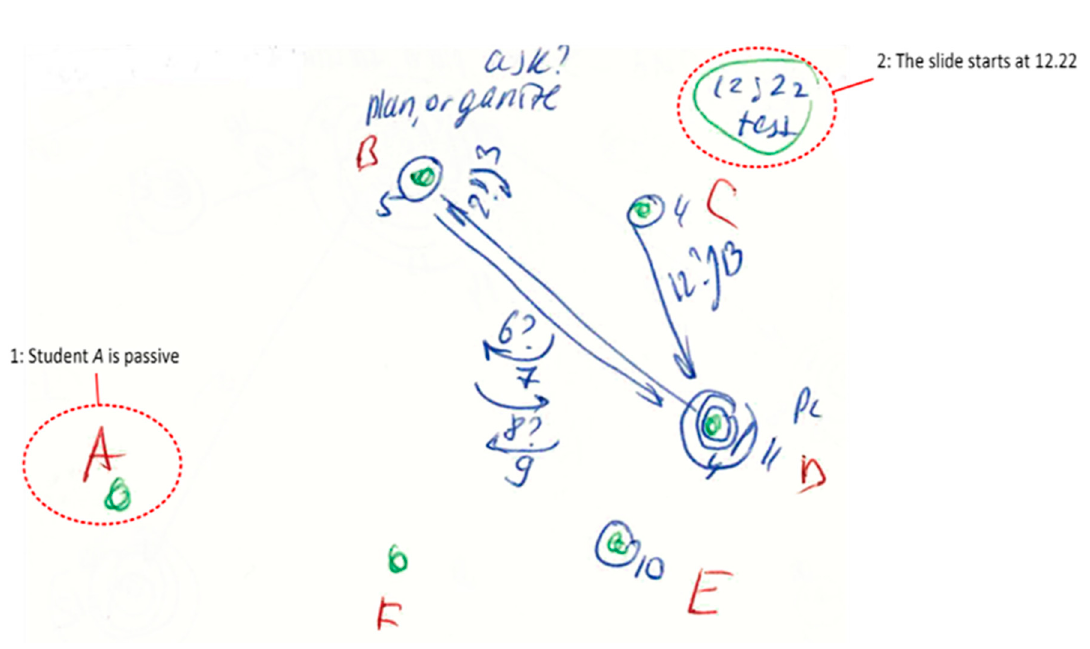
Figure 1. Interaction Diagram: communication situation 1 [reproduced from [33] by permission].